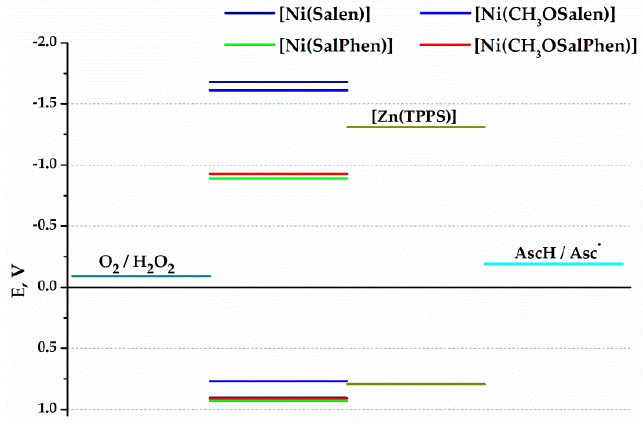
Figure 5. Electrochemical energy level diagram for NiSalen polymers, porphyrin salt, oxygen and ascorbic acid.